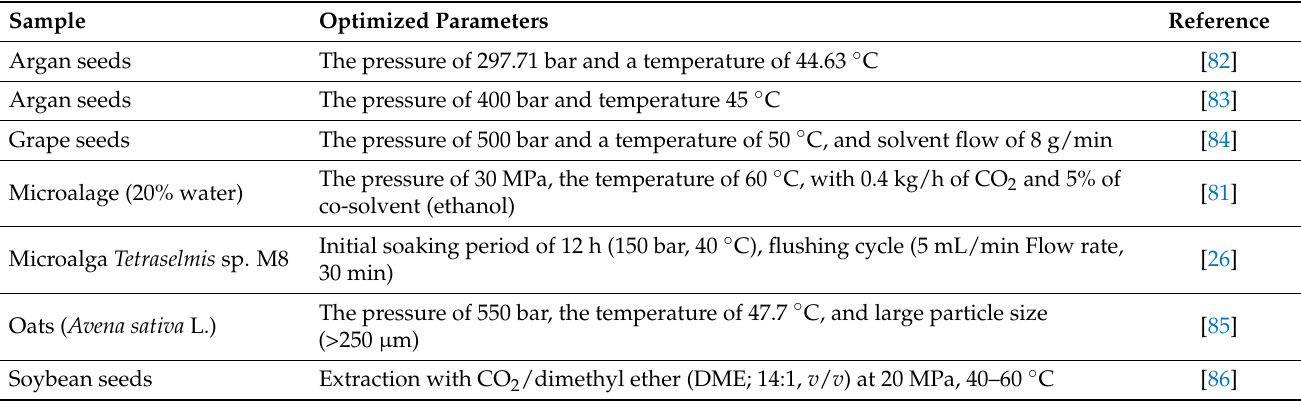
Table 3. The optimized parameters of supercritical CO 2 extraction of